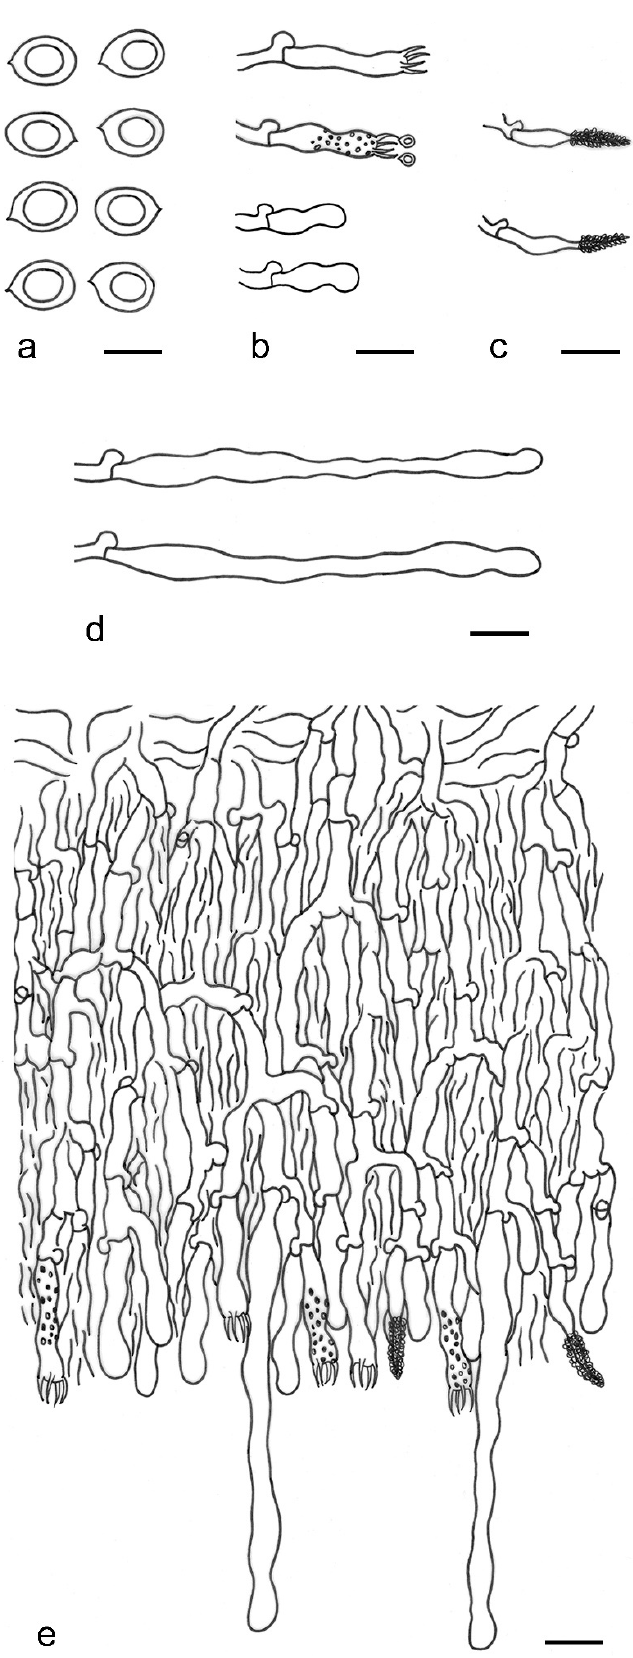
Figure 27. Microscopic structures of Xylodon lagenicystidiatus (drawn from the holotype). ( a ) Basidiospores; ( b ) basidia; ( c ) lagenocystidia; ( d ) leptocystidia; ( e ) a section of the basidiocarp.—Scale bars: a = 5 μ m; b–e = 10 μ m.